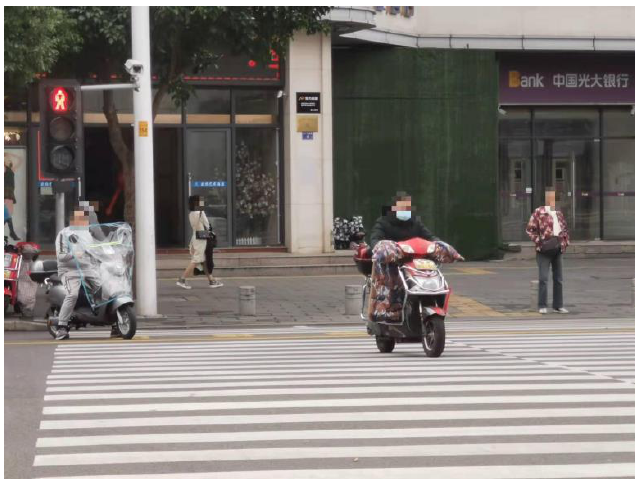
Figure 3. Red-light running behavior of e-bikers.